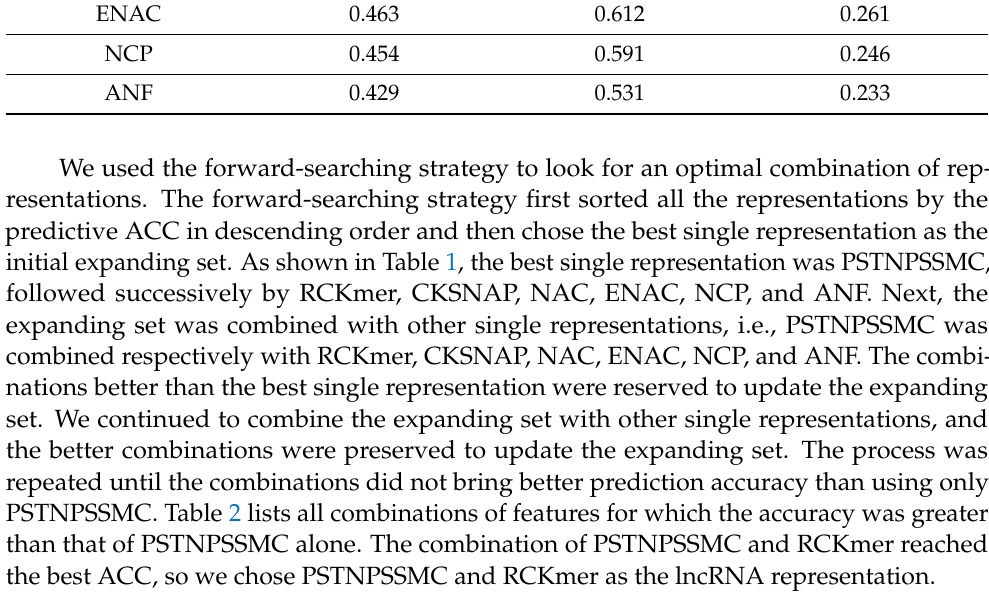
Table 2. Performance using LightGBM on combinations of different representations under 5-fold